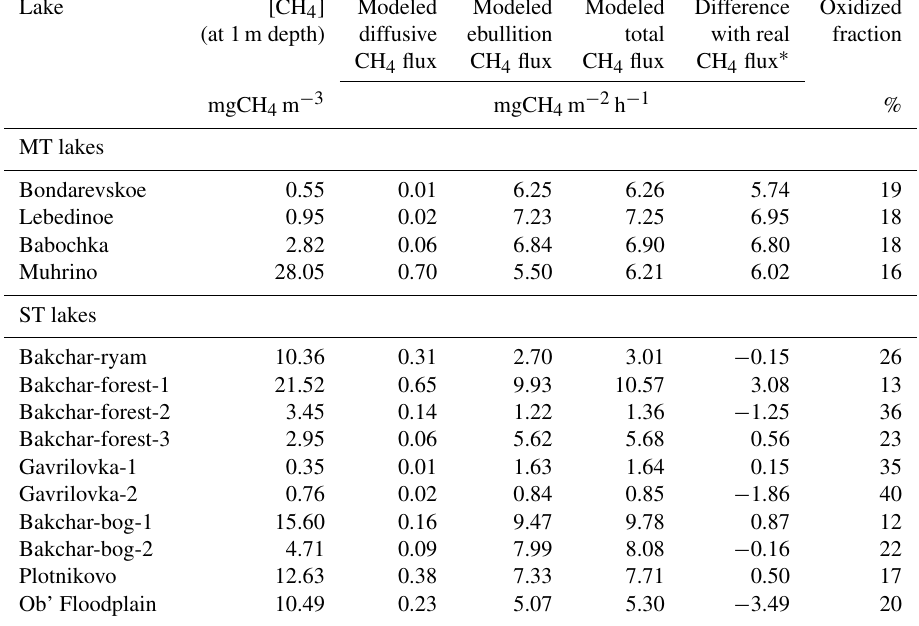
Table 4. Summary of modeling